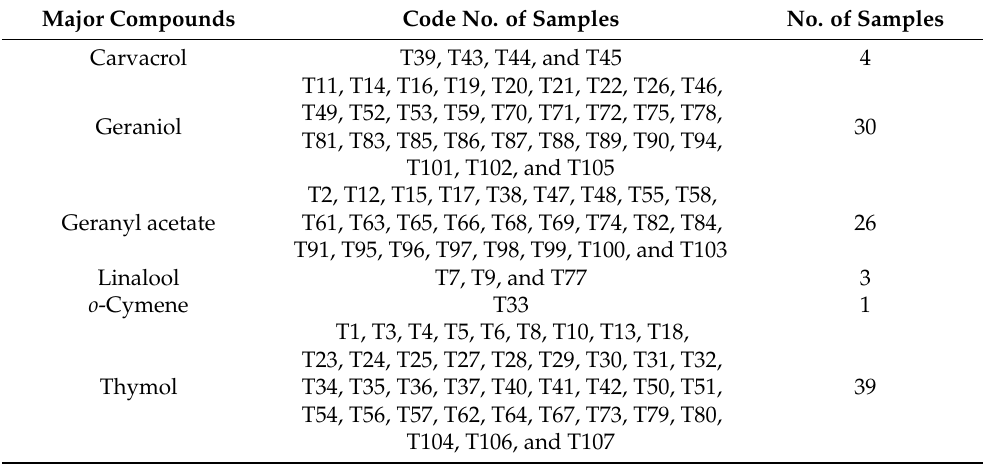
Table 3. Chemotype classification of T. quinquecostatus